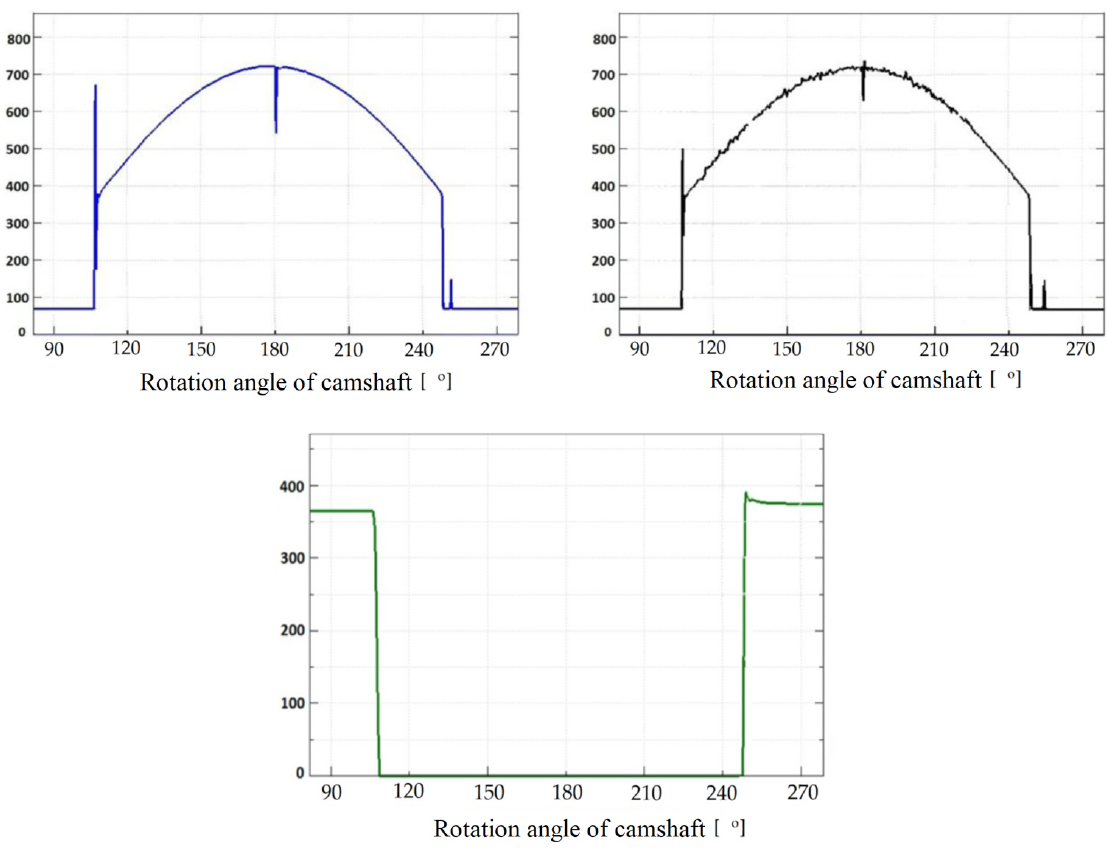
Figure 11. Contact forces between cam and tapet [N] for n AD = 350 rpm.